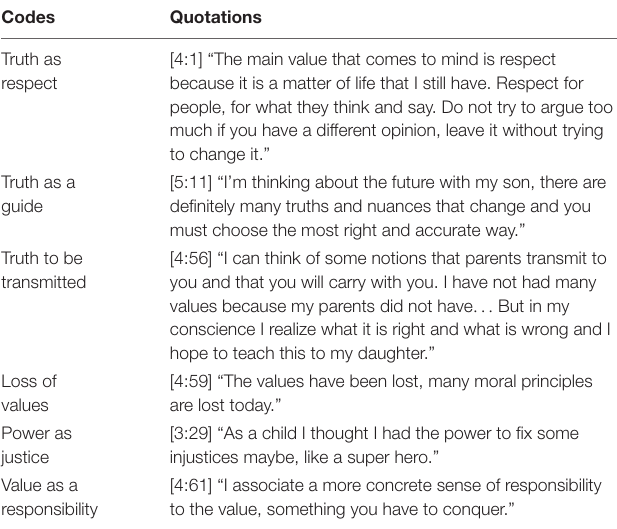
TABLE 3 | Indicators about “Ethics and Justice” code